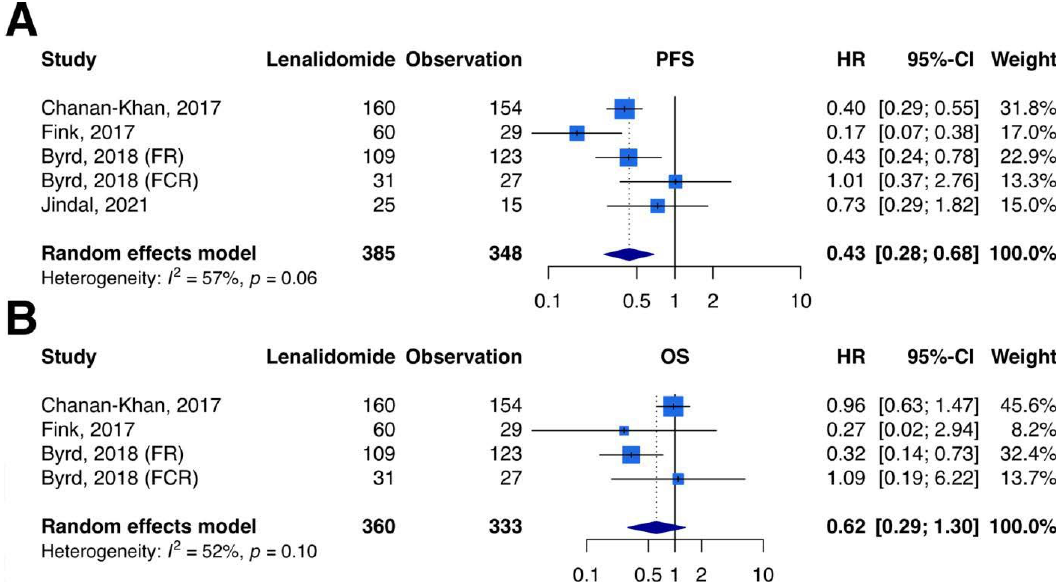
Figure 2. Meta-analysis of primary outcomes regarding ( A ) progression-free survival and ( B ) overall survival. PFS, progression-free survival; OS, overall survival; HR, hazard ratio; CI, confidence interval. ( A ) Meta-analysis of progression-free survival. Analysis included data from 5 comparisons with a total of 385 patients receiving lenalidomide maintenance therapy and 348 patients receiving observation alone. The p -value for heterogeneity was 0.06, and I-squared for heterogeneity was 57%, indicating moderate heterogeneity. We adopted a random-effects model, and lenalidomide maintenance therapy was associated with a statistically significant effect in the prolongation of PFS (HR, 0.43; 95% CI, 0.28–0.68). ( B ) Meta-analysis of overall survival. Analysis included data from 4 comparisons with a total of 360 patients receiving lenalidomide maintenance therapy and 333 patients receiving observation alone. The p -value for heterogeneity was 0.10, and I-squared for heterogeneity was 52%, indicating moderate heterogeneity. We adopted a random-effects model, and lenalidomide maintenance showed no difference in OS compared with the observation (HR, 0.62; 95% CI,